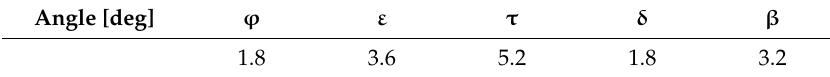
Table 3. Angular errors of the finger joints and driving